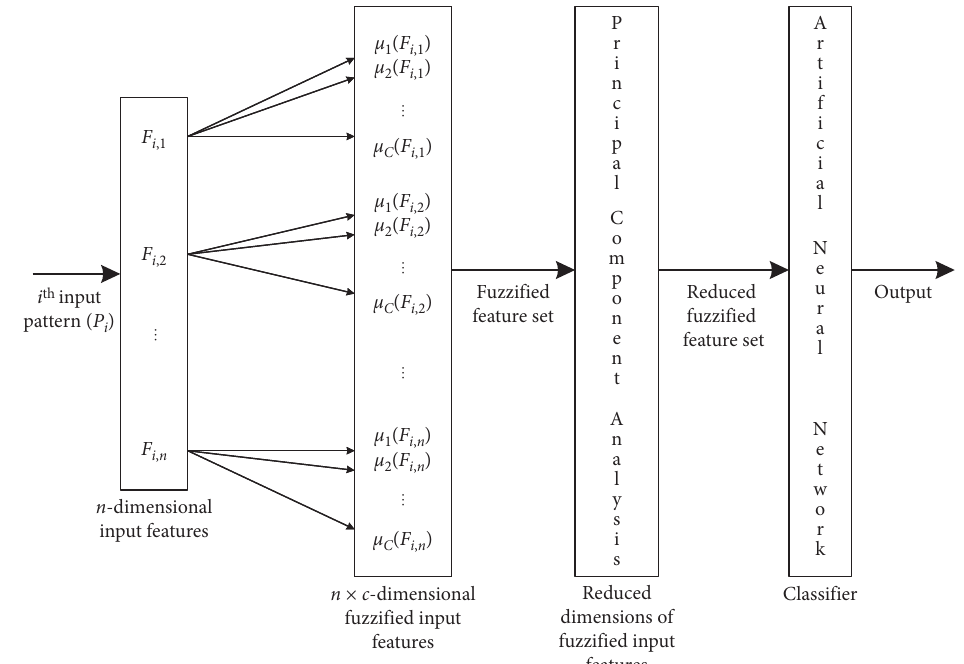
Figure 2: Framework of the NF-FR